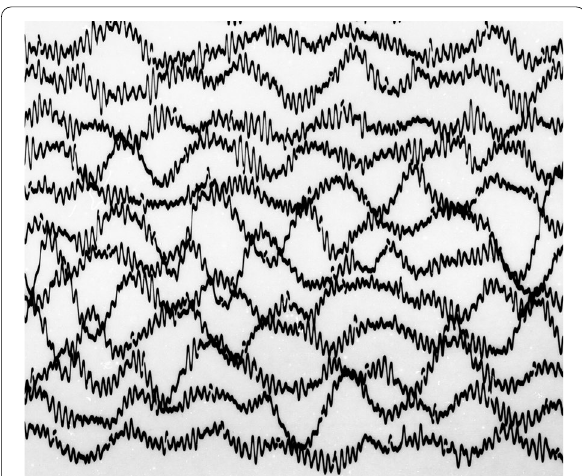
Fig. 10 An example of crossing/touching traces. A portion of the long-period north–south recording from BKS (Berkeley, CA) on February 11, 1964. One can take advantage of the time marks that are horizontally offset for each trace to unravel most parts of this image, but if time marks were occurring at the same horizontal position, one would have a hard time separating the